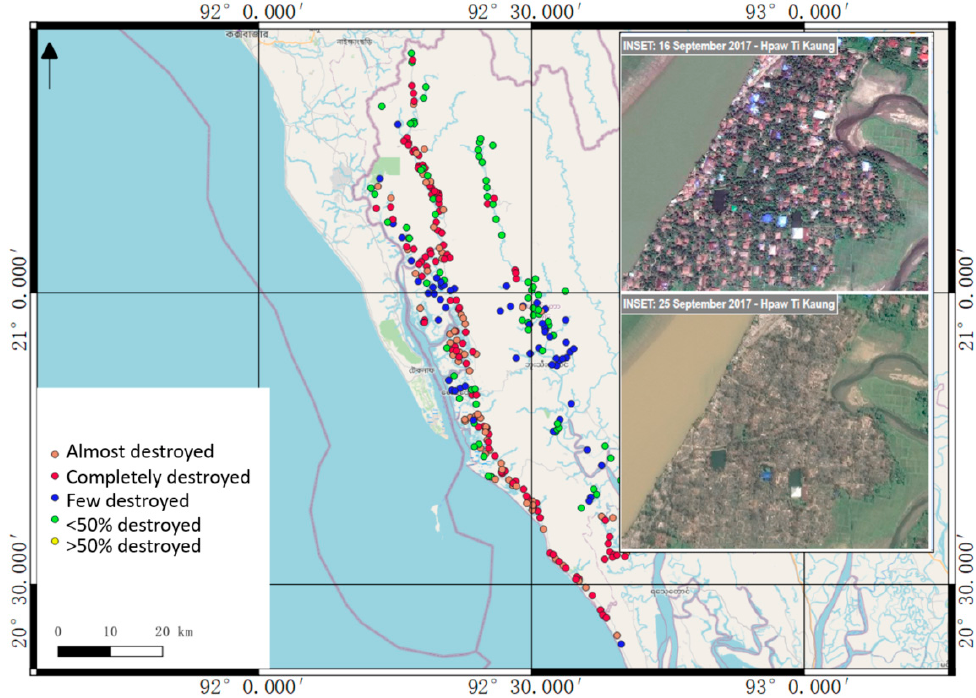
Figure 10. Areas of satellite-detected destroyed or otherwise damaged settlements in Northern Rakhine State in Myanmar. Inset figures showing destroyed villages (Source: UNITAR/UNOSAT).